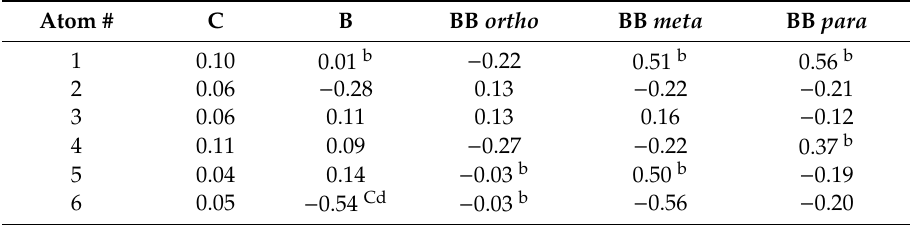
Table 4. Mulliken charges for the atoms on the central ring in the coronene models. The numbering of atoms and naming of system is as shown on Figure 1 and Table 3. The substituted boron atoms are identified by a superscript ‘b’. The distorted C d atom is identified by a superscript ‘Cd’.